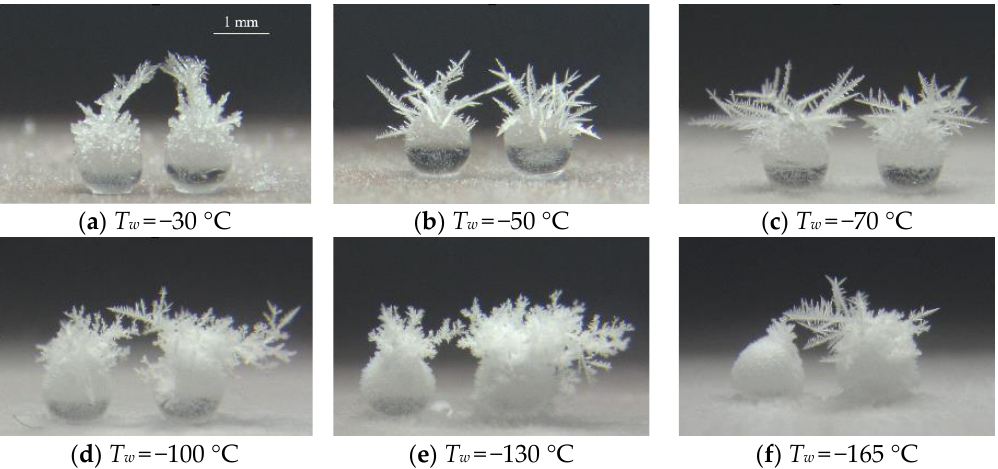
Figure 9. Experimental phenomenon when dendrites intersect ( T a = 15 °C, φ =